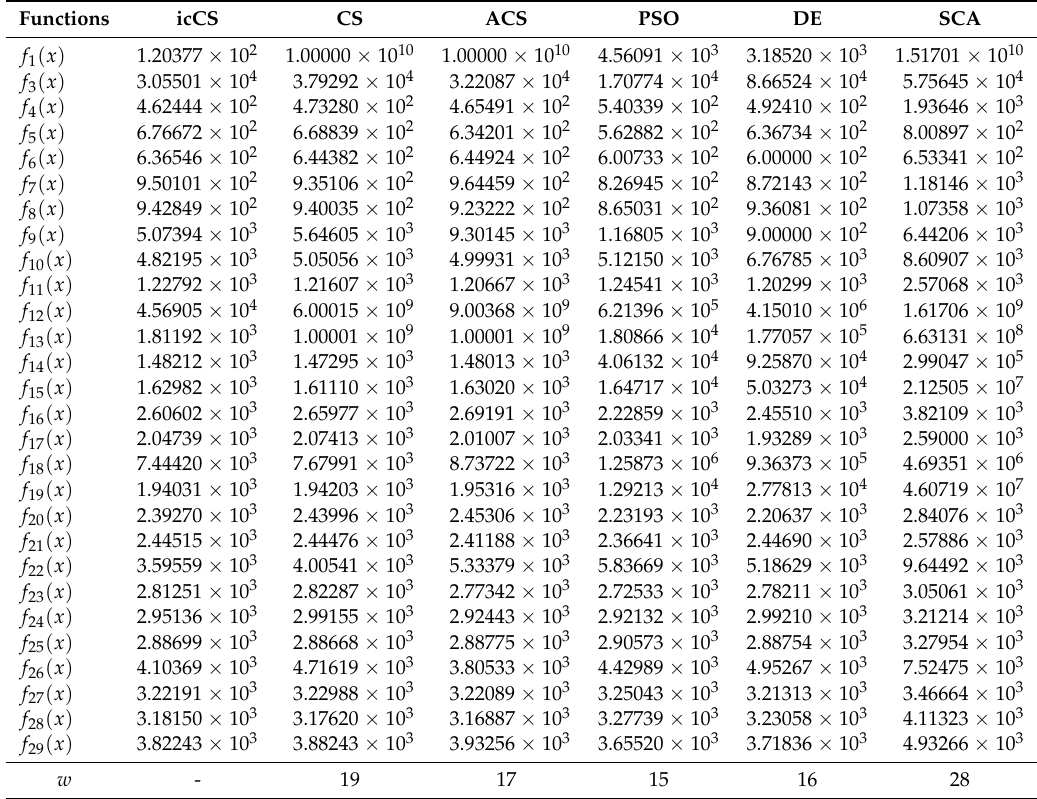
Table 2. Comparison of means of fitness functions on 30D optimization among CS, ACS, PSO, DE, SCA, and icCS is presented